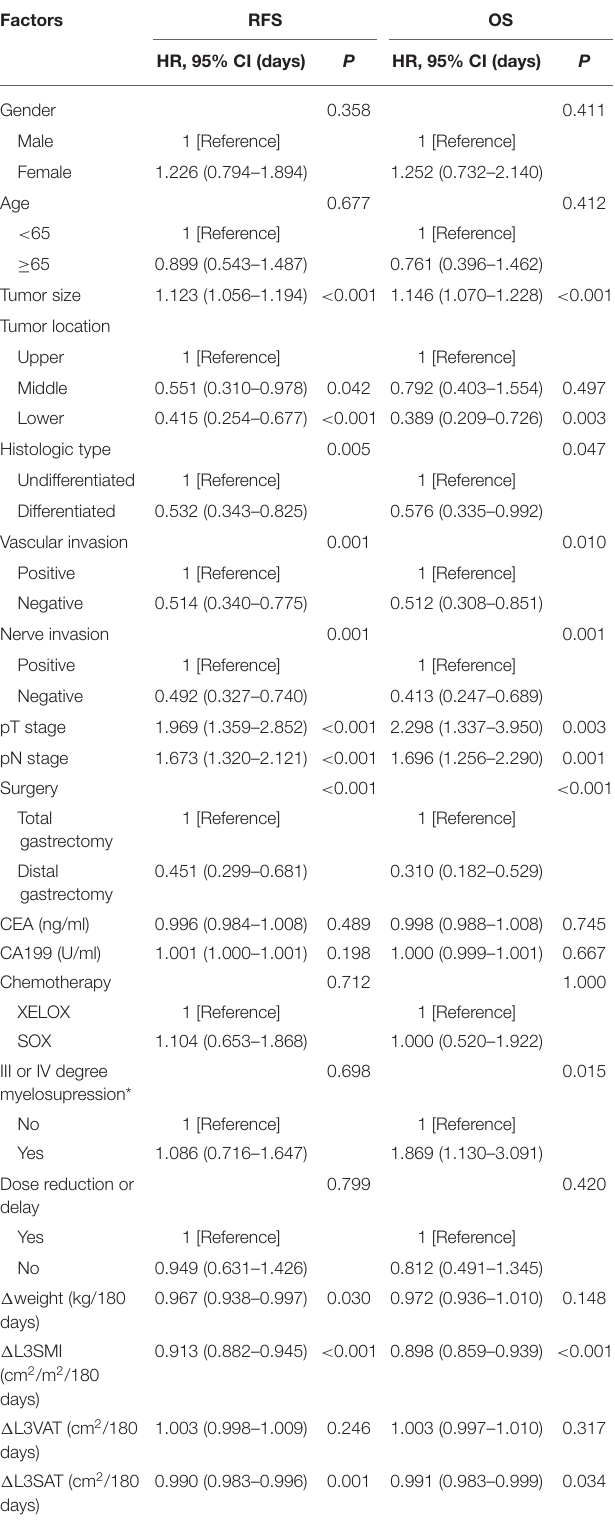
TABLE 2 | Univariate Cox analysis for replase-free survival and overall survival stratified by clinical factors.